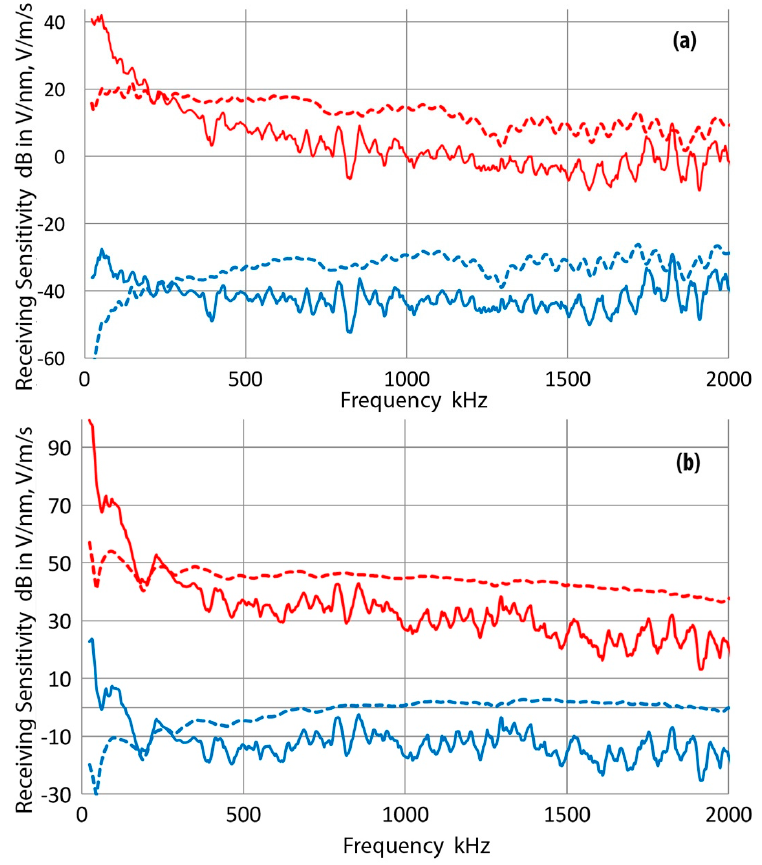
Figure 10. ( a ) Receiving sensitivity of Valpey-Fisher Pinducer. The displacement receiving sensitivities are shown in blue curves and velocity sensitivities are in red. Solid lines are for the bar-wave data, while dashed curves are for the sensitivities to normally incident waves; ( b ) Receiving sensitivity of DWC B1080-LD. The displacement receiving sensitivities are shown in blue curves and velocity sensitivities are in red. Solid lines are for the bar-wave data, while dashed curves are for the sensitivities to normally incident waves.